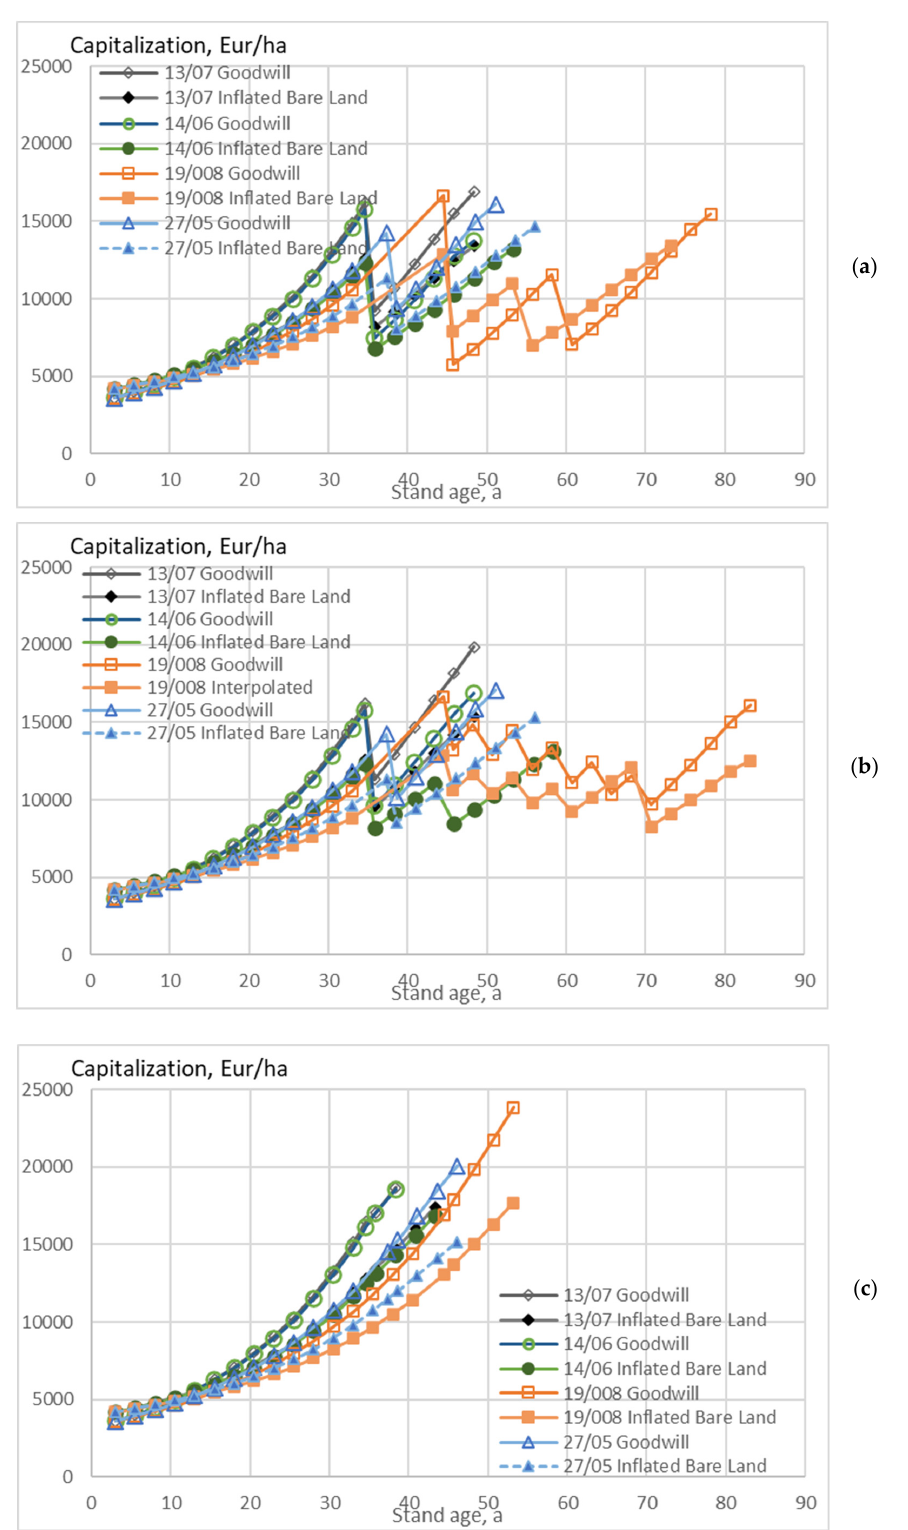
Figure 6. Stand capitalization as a function of stand age, when the growth model is applied to four observed wooded stands, without any thinning restriction ( a ), in good-quality trees of at least 238 mm of diameter only removed in thinning ( b ), and without any commercial thinning ( c ). Inflated capitalization is introduced either as proportional goodwill or as inflated bare land value; the numbers in legends identify stands and observation plots.